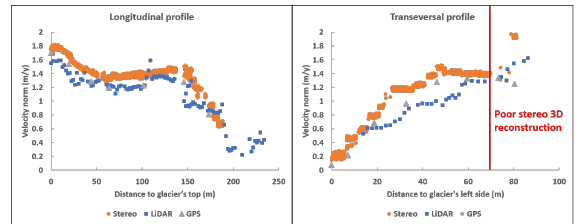
Figure 10. Velocity profiles of the Laurichard glacier from GPS, DEM and stereo. The profiles follow the GPS measurements which are presented in Figure 9. The stereo profile is closer to the GPS measurements and is less noisy even if the velocity seems overestimated.